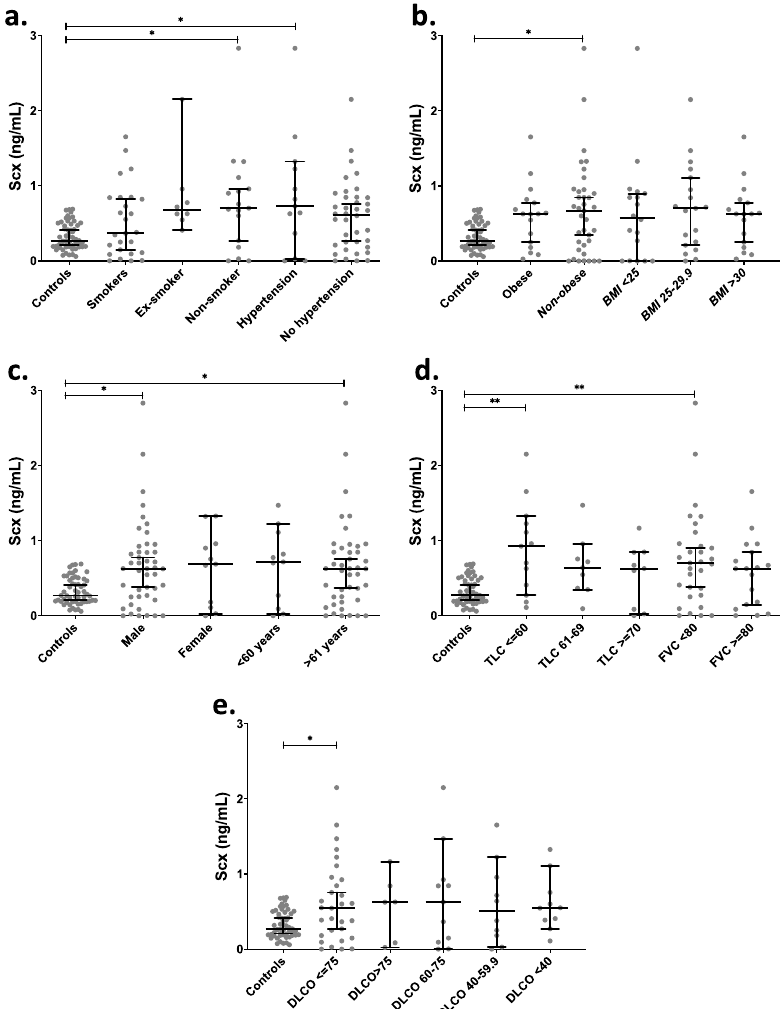
Figure 5. IPF patients with severely a ff ected pulmonary function showed higher levels of circulating SCX. SCX serum levels grouped by ( a ) smoking habit and hypertension, ( b ) BMI, ( c ) sex and